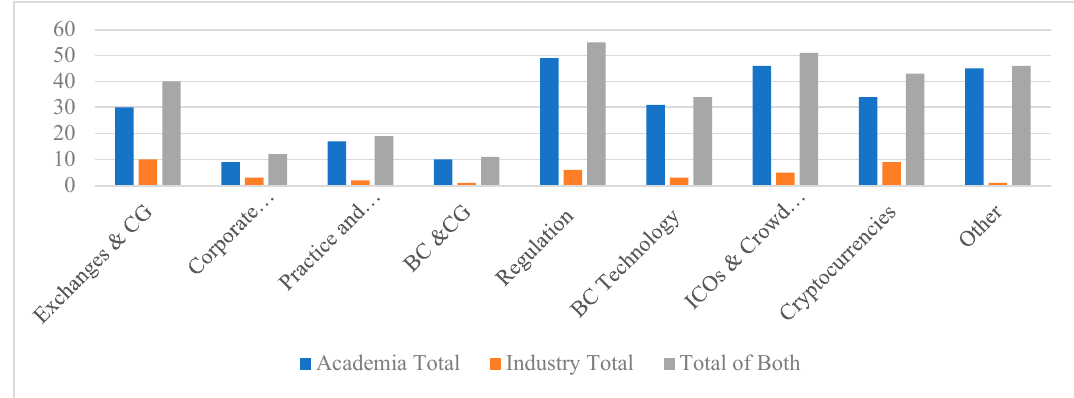
Figure 2. Topic-wise article count for academic and industry articles and total aggregate.